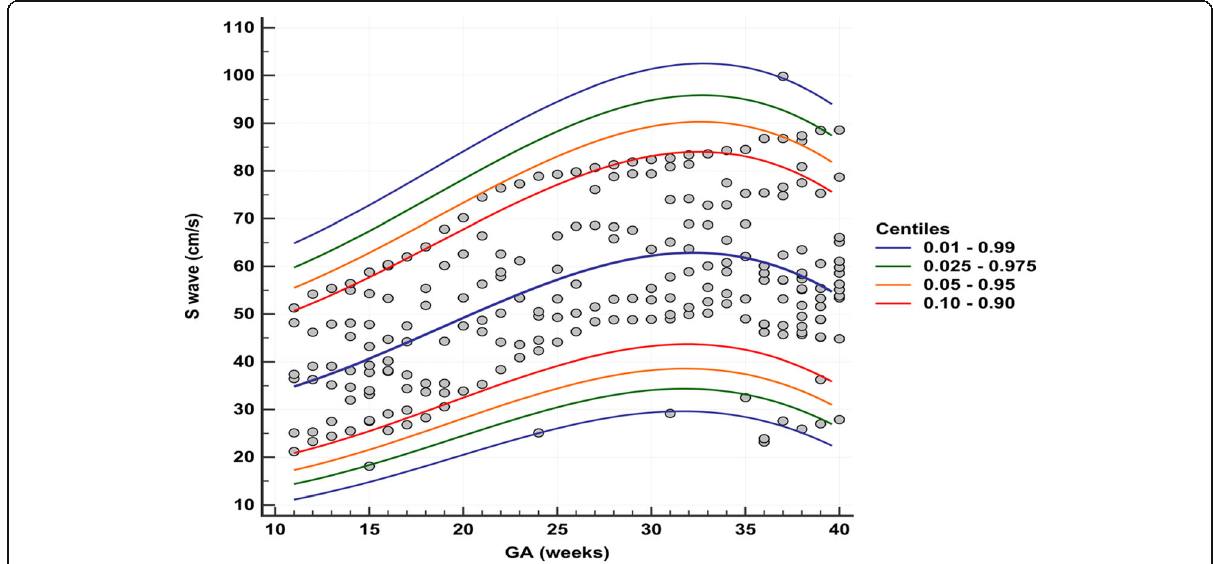
Fig. 6 Scattered diagram of gestational age individual measurement and calculated reference ranges for DV S wave velocity in normal pregnancies (690 observations) with 1th – 99th percentiles (blue lines)